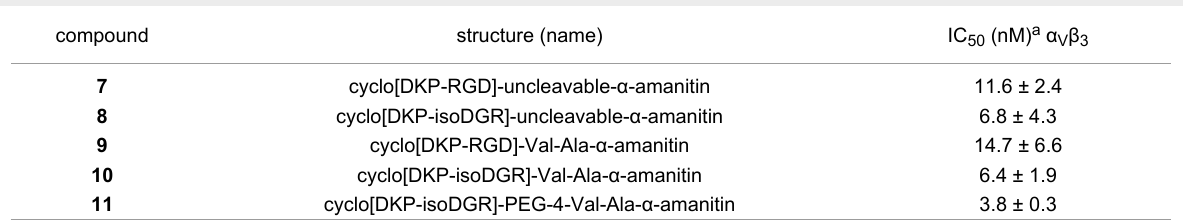
Table 2: Inhibition of biotinylated vitronectin binding to α v β 3 receptor. compound structure